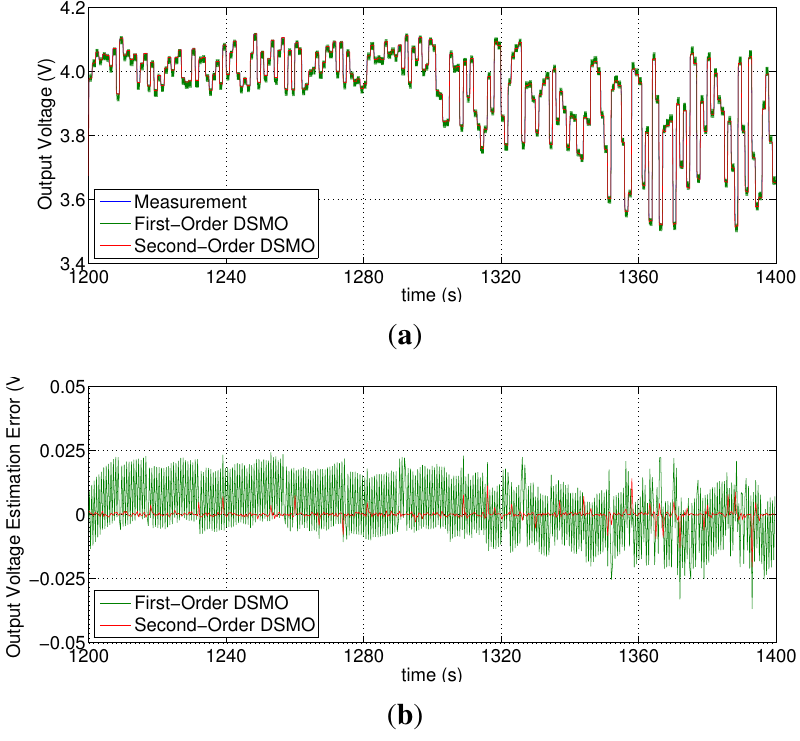
Figure 9. One-cycle estimation results for the proposed method: ( a ) output voltage estimation; and ( b ) estimation errors.